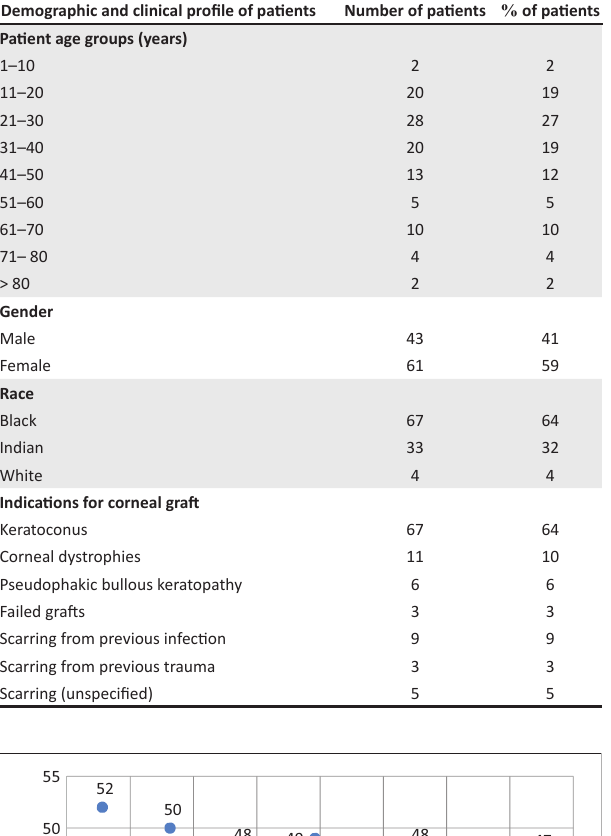
TABLE 1: Demographic and clinical profile of patients on the corneal graft wait- ing list in the eThekwini Health District, 2011–2014. Demographic and clinical profile of patients Number of patients % of patients Patient age groups (years)